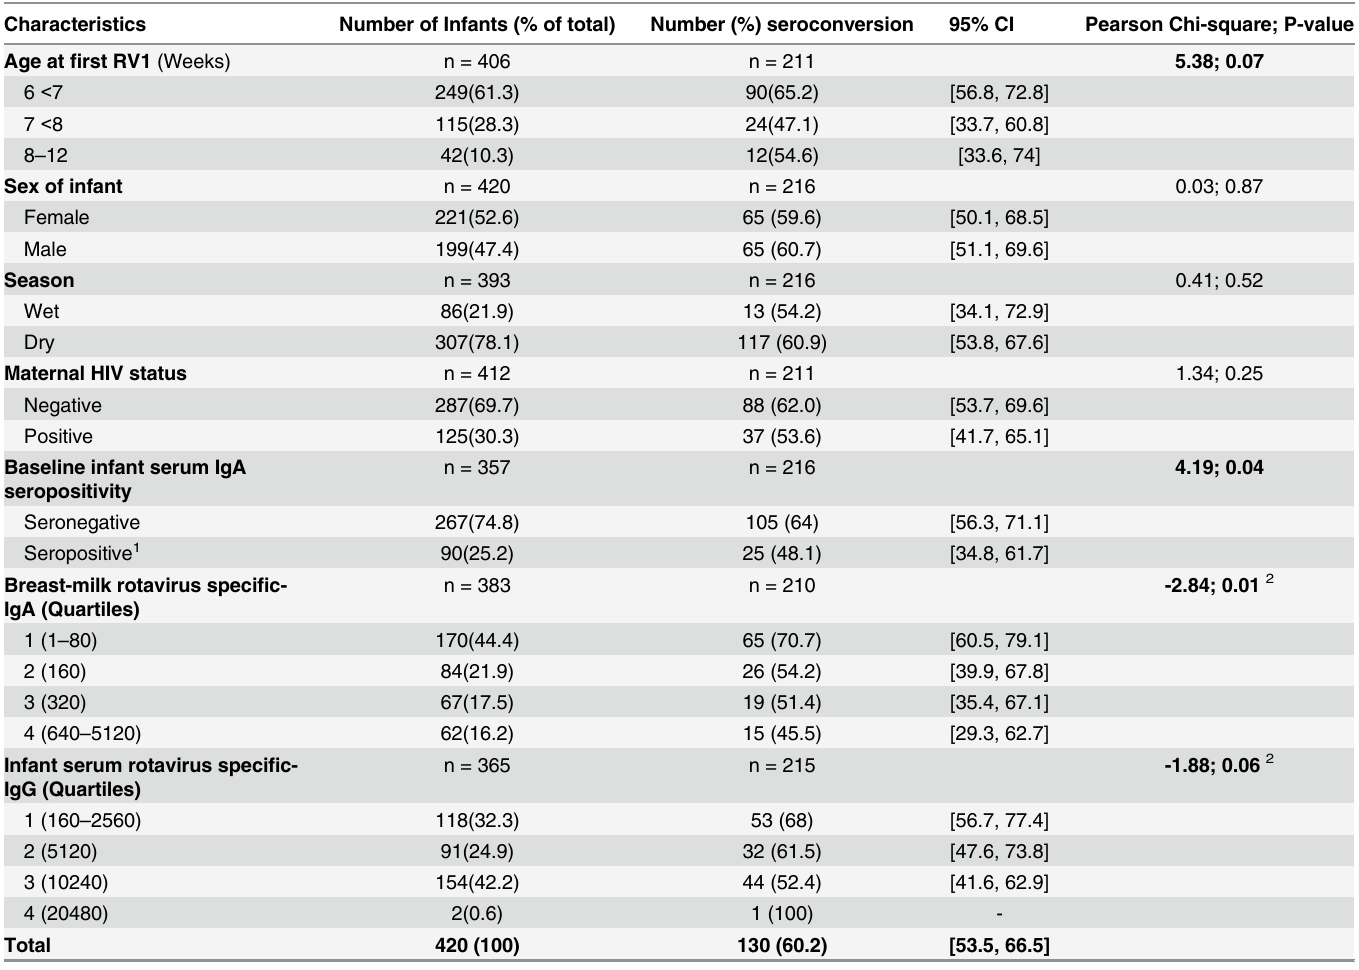
Table 1. Percentage of infants seroconverted * by infant and maternal factors, in Lusaka.